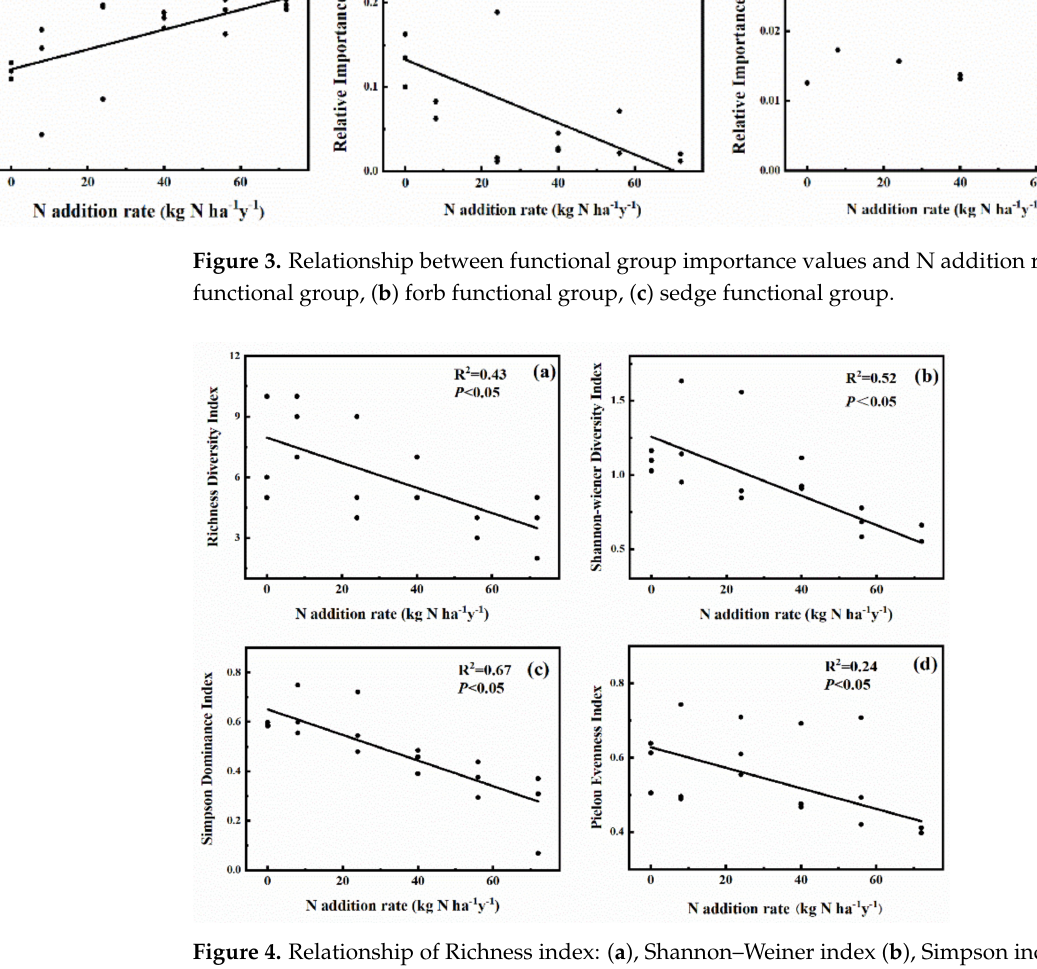
Figure 4. Relationship of Richness index: ( a ), Shannon–Weiner index ( b ), Simpson index ( c ), Pielou evenness index, ( d ) with N addition